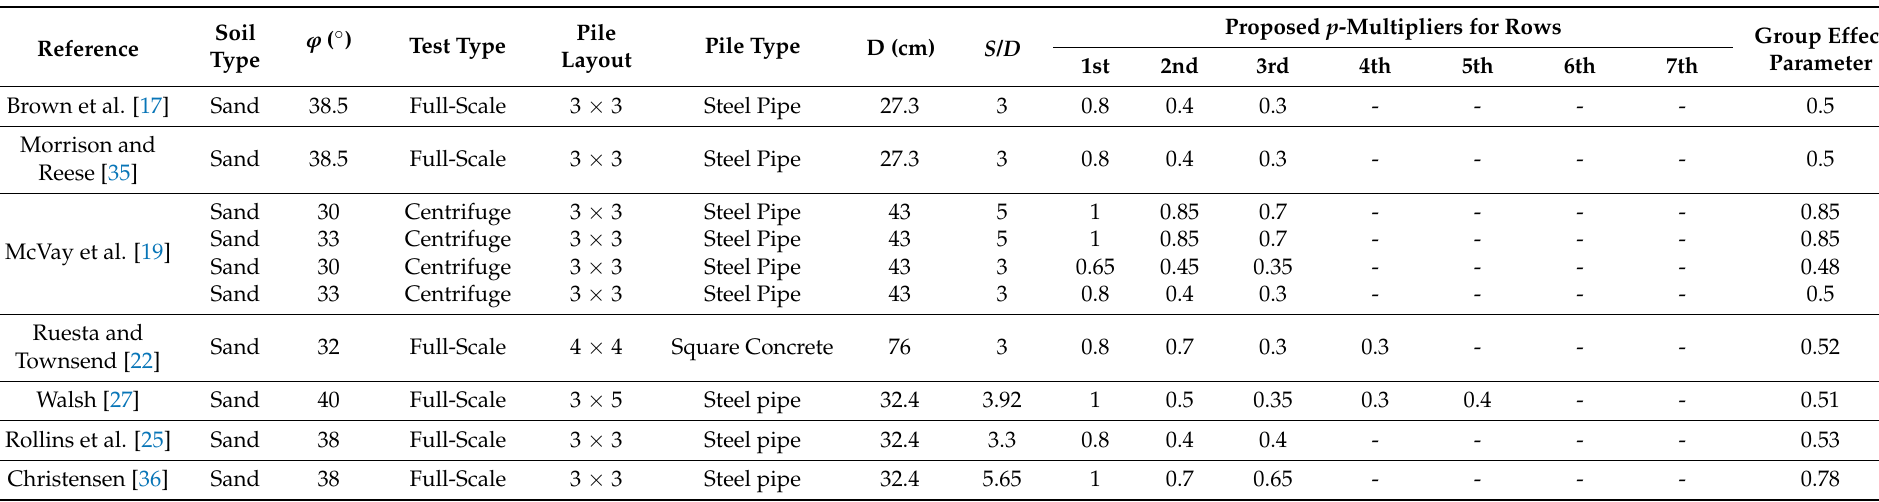
Table 1. Previous experimental studies conducted on free-head pile groups (modified after Fayyazi